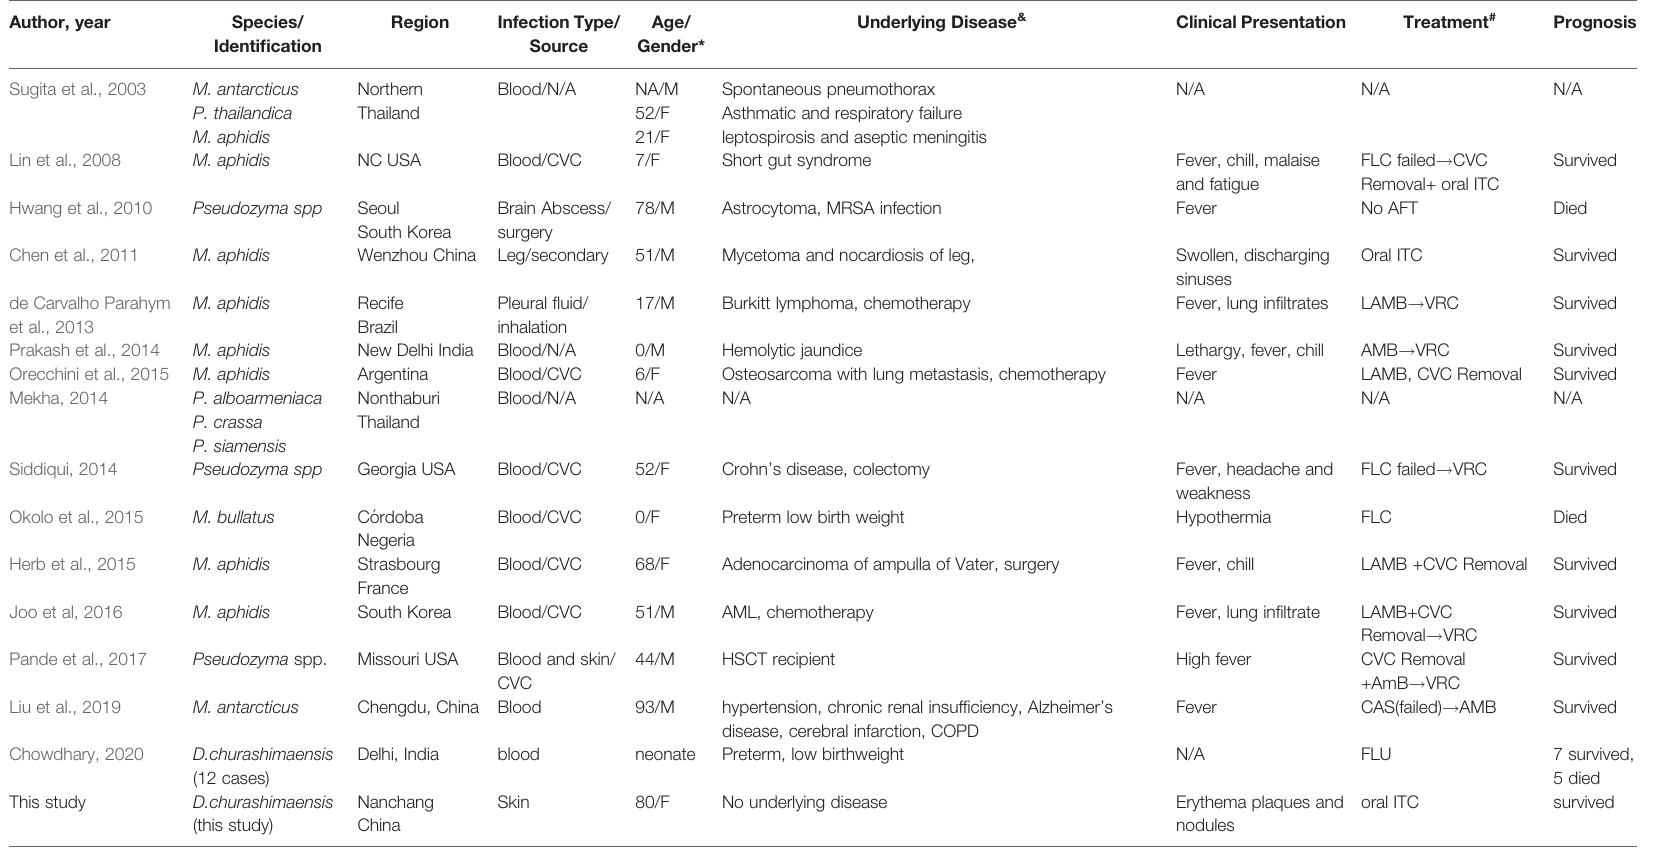
TABLE 1 | Clinical information of Ustilaginales infections in